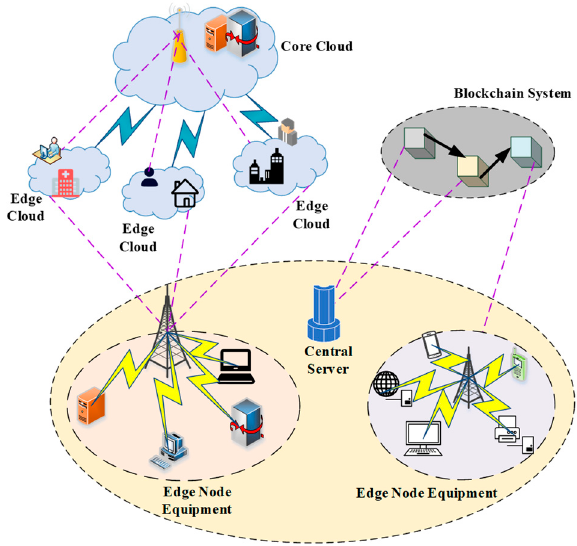
Figure 1. Structure of RMS by task offloading.